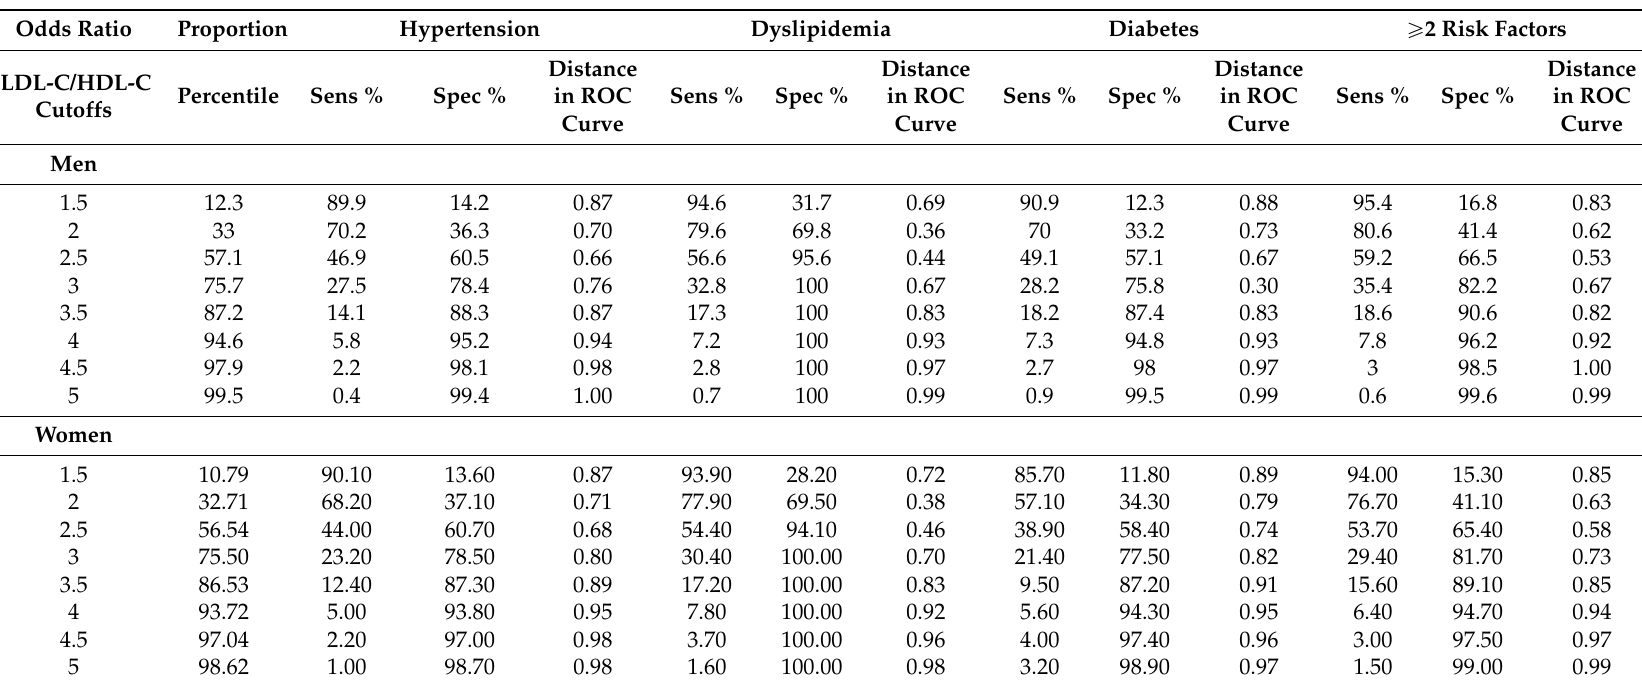
Table 5. Sensitivity (Sens), specificity (Spec), and distance in the receiver operating characteristic (ROC) curve for LDL-C/HDL-C ratio cutoff points in the Uygur